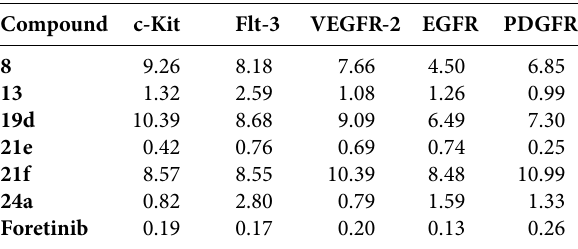
Table 4. inhibitory effect of compounds 8, 13, 19d, 21e, 21f and 24a towards tyrosine kinases [Enzyme IC 50 (nM)] Compound